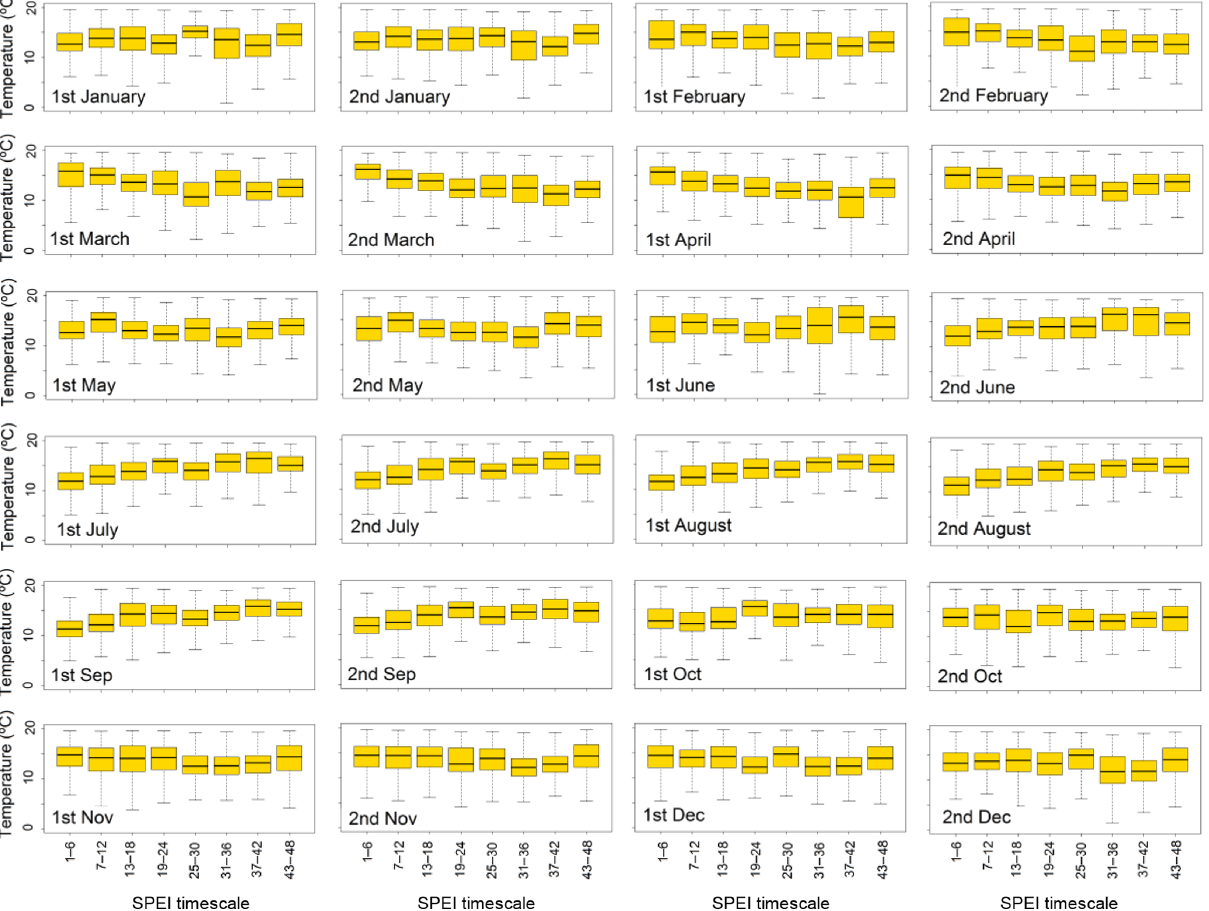
Figure 11. Box plots showing air temperature values, as a function of the SPEI timescales at which the maximum correlation between the sNDVI and SPEI is